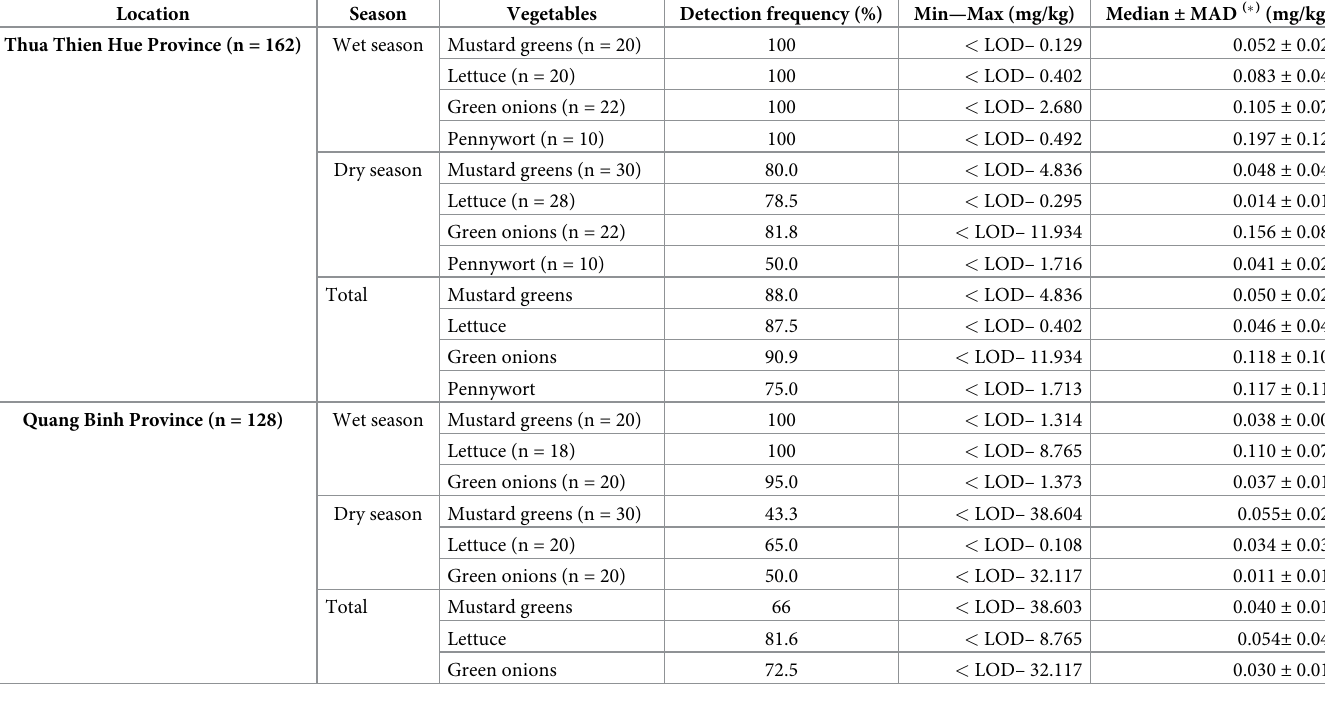
Table 2. Total pesticide concentrations (mg/kg) and detection frequencies (%) in vegetables collected in Thua Thien Hue and Quang Binh provinces. Location Season